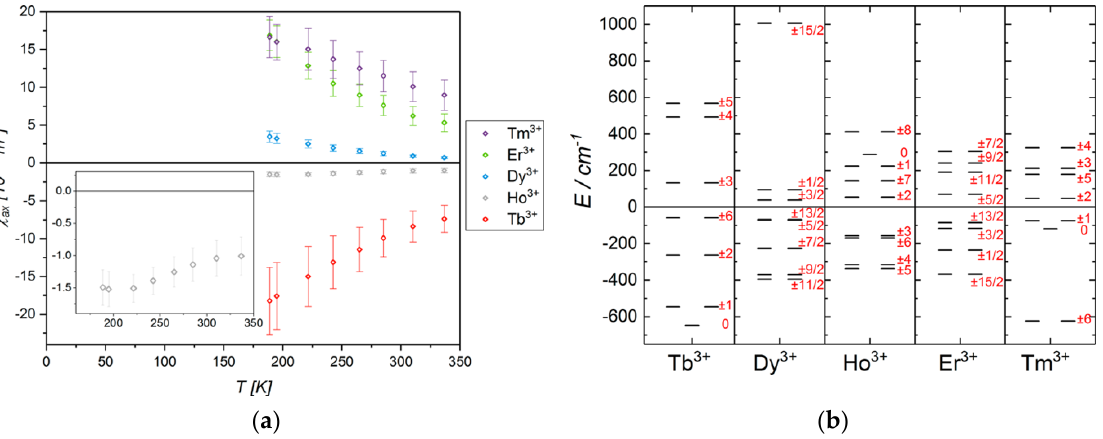
Figure 7. Temperature dependence of the magnetic susceptibility anisotropies ( a ), and relative energies of the different m J sublevels obtained from the fitted Ligand Field parameters ( b ). The investigated compounds are the Ln(tdnCOT) 2 − series (tdnCOT = (6Z,14Z)-5,8,13,16-tetrahydrocycloocta [1,2-b:5,6-b’]-dinaphtalene; the values for the Ho 3+ analogues are enlarged in the inset). Reprinted with permission from ref. [37]. Copyright 2017 American Chemical Society.